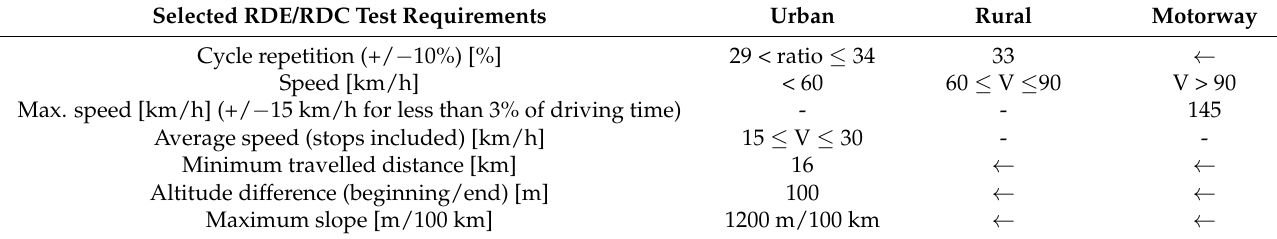
Table 1. Real Driving Conditions test requirements